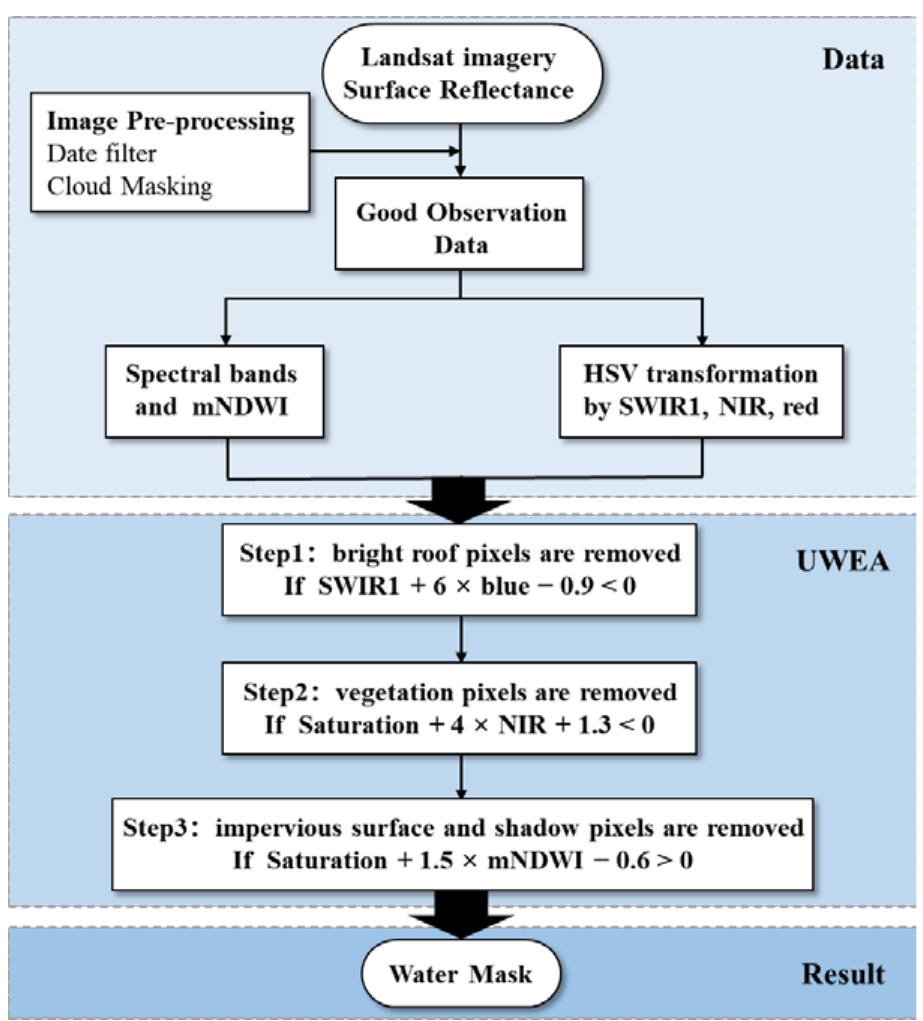
Figure 3. Flow chart of the UWEA water extraction process.